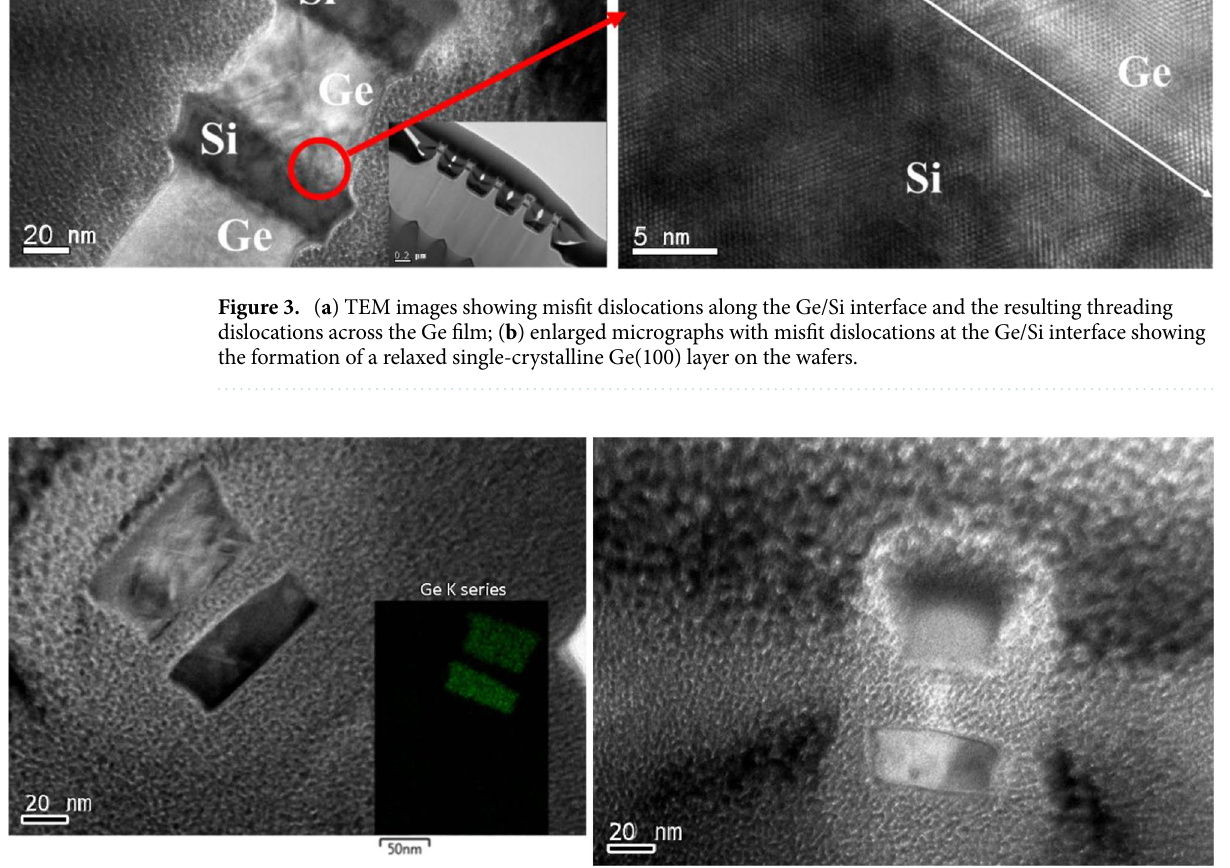
Figure 4. Cross-sectional TEM images of stacked Ge nanosheets ( a ) before and ( b ) after annealing. The latter show that the dislocations can be easily removed by forming gas annealing (600 °C/5 min) of the suspended sheets.